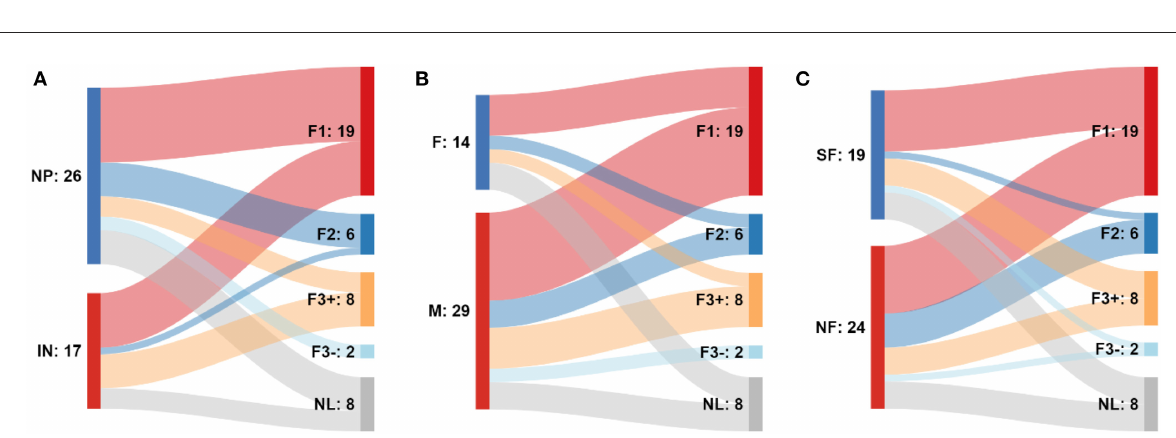
, F3-) with respect to their countries, roles and gender. +